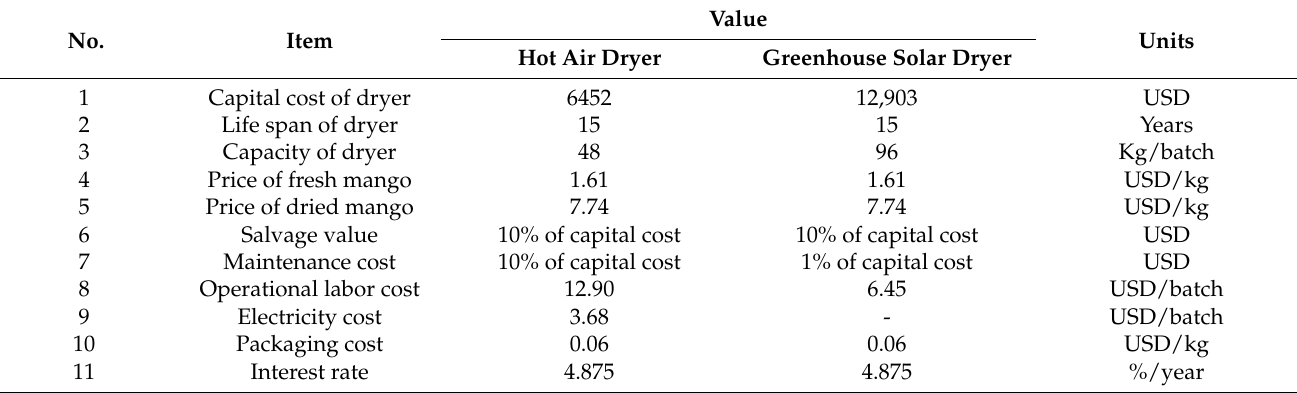
Table 3. Details for computation of economic analysis.